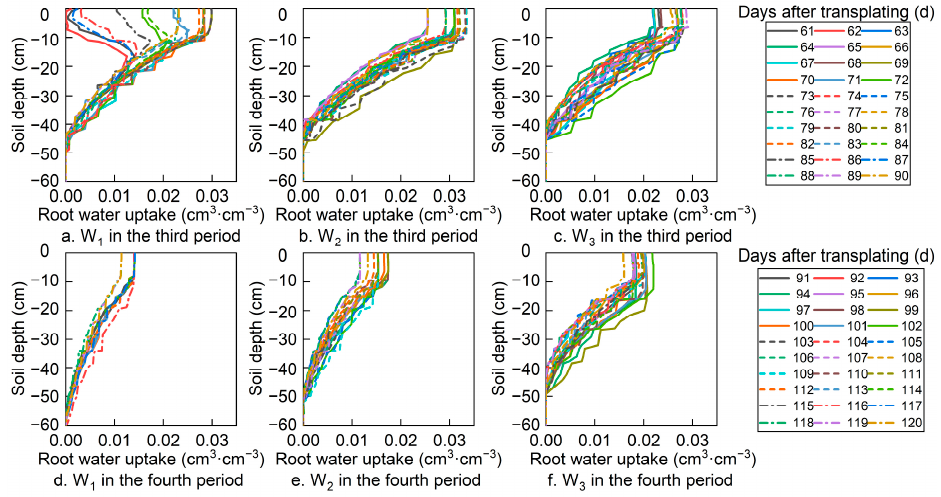
Figure 7. Water absorption of tomato roots (cm 3 ·cm − 3 ) in the 0–60 cm soil layer under different water treatments in blooming and setting stage and fruiting stage, in 2020. treatments in blooming and setting stage and fruiting stage, in